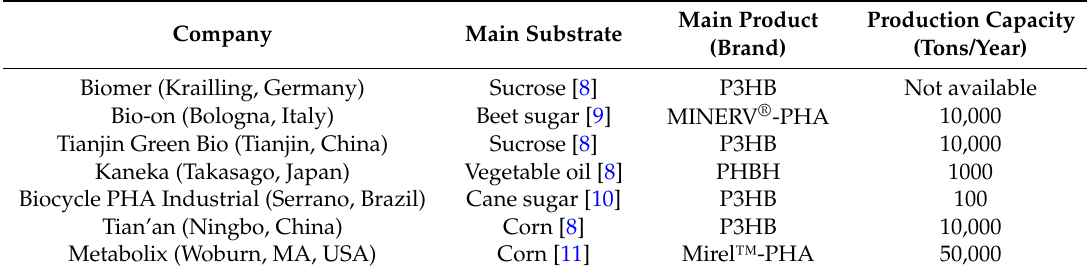
Table 1. Main polyhydroxyalkanoate (PHA) producers and their substrate. Company